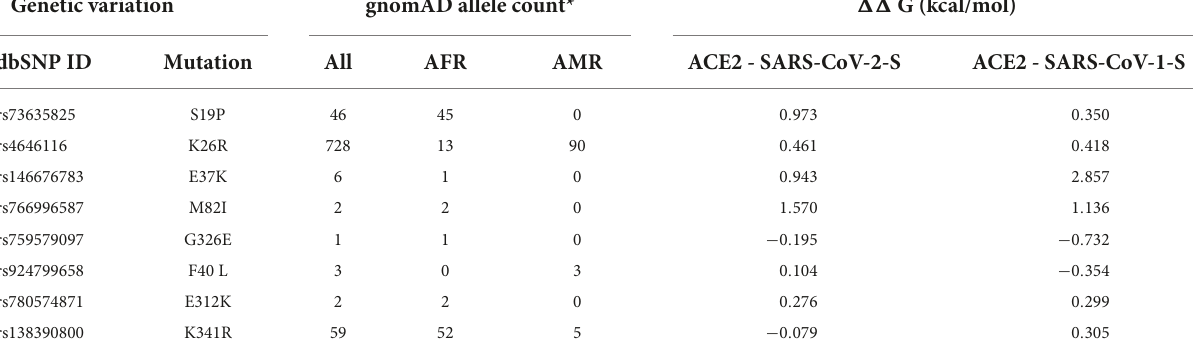
TABLE 2 Key genetic variants altering ACE2 stability in African/Latino Americans. Genetic variation gnomAD allele